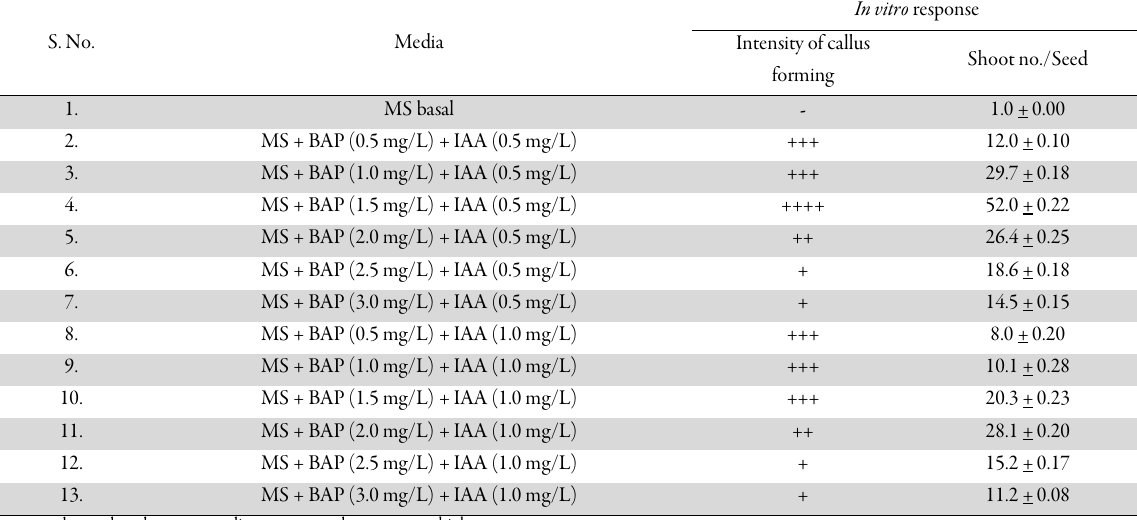
Table 1. Evaluation of media for callus formation and multiple shoots proliferation from mature seed explants of Withania somnifera (L.) Dunal S. No.